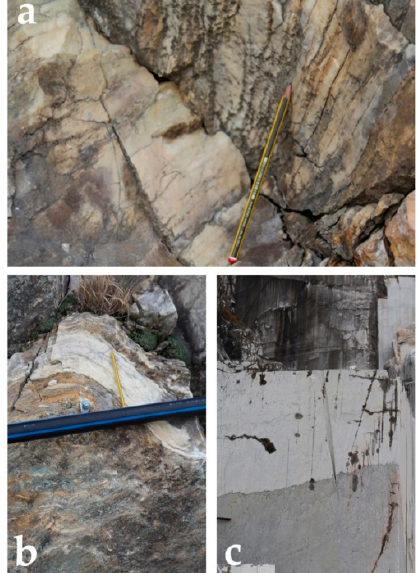
Figure 3. Outcrop appearance of the lithologies of the study area: ( a ) Megalodon-bearing marble, ( b ) Seravezza breccia, ( c ) contact between white and grey marbles.